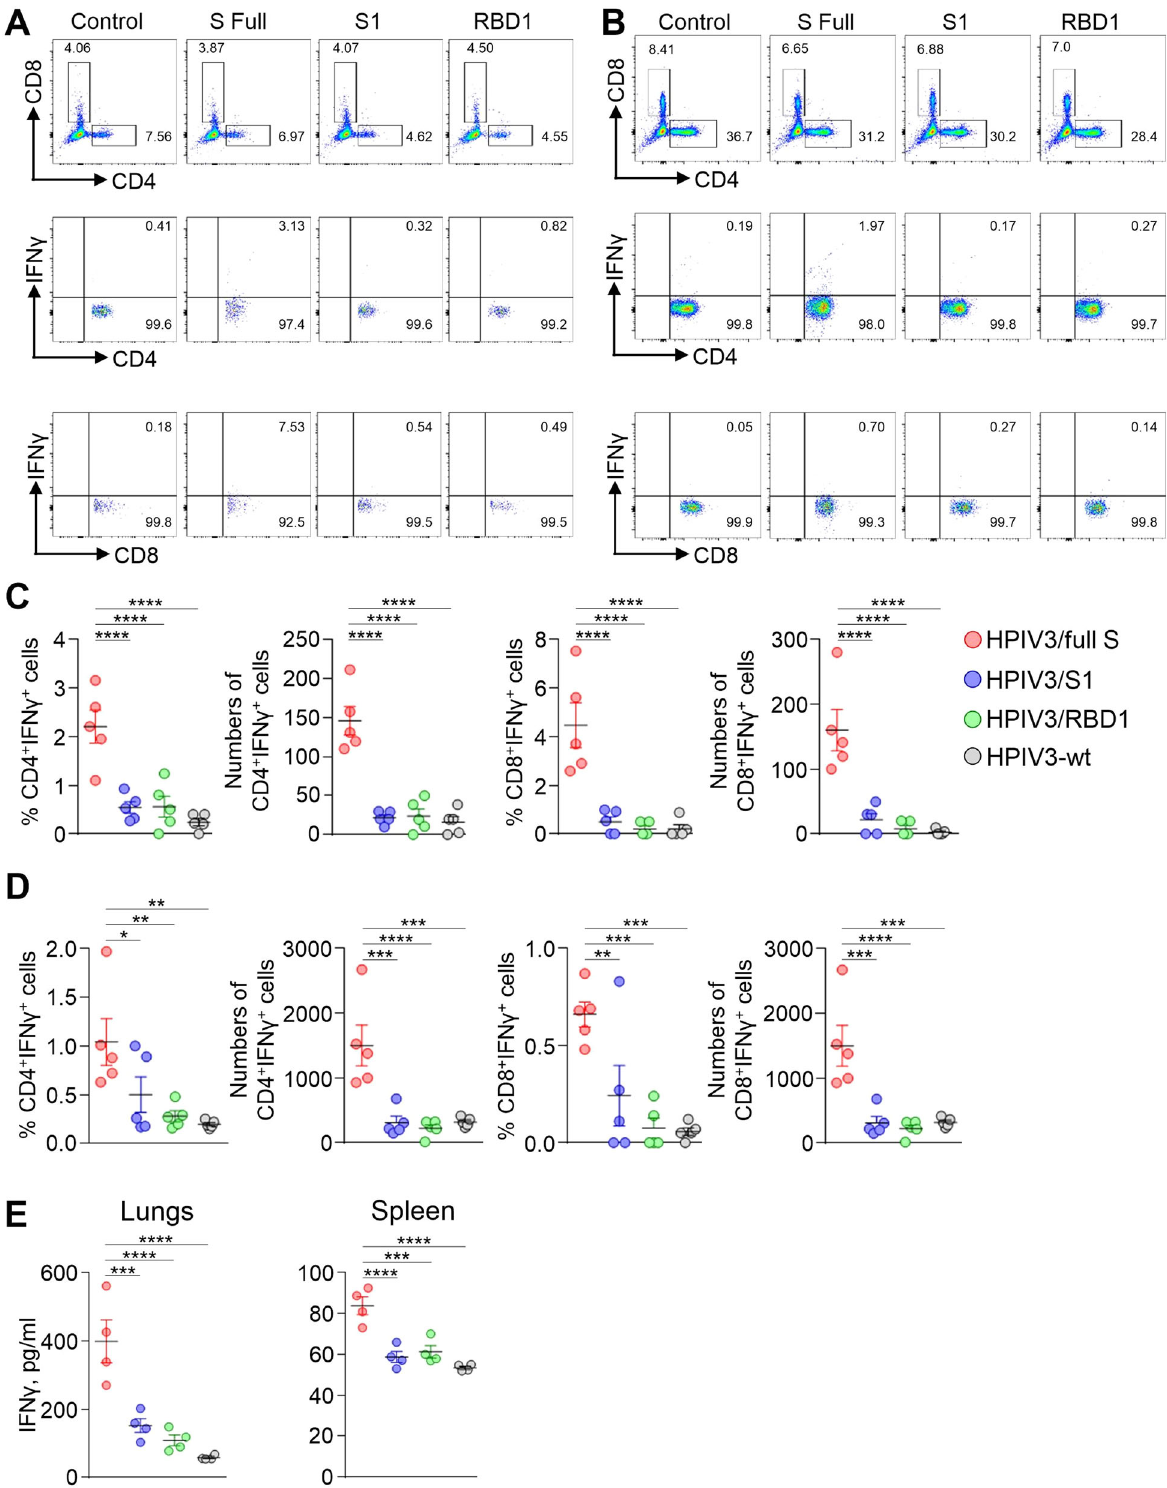
Fig. 4 Cell-mediated response to vaccination in lungs and spleen. A – D Cells isolated from tissue samples of uninfected animals at 28 days post vaccination were stimulated with SARS-CoV-2 S-peptide pool and stained for CD4, CD8 and IFN γ markers. A and B . Representative histograms show the frequency of CD4 + and CD8 + T cells (gated from lymphocyte population) and IFN γ -positive CD4 + or CD8 + T cells following treatment with S peptides in lungs ( A ) or spleen ( B ). C and D Frequency and absolute numbers of T cells per 10 6 total lung cells ( C ) or spleen cells ( D ). E IFN γ secretion by lung and spleen cells at 28 days post vaccination. Cells were isolated from tissue samples of uninfected animals and stimulated with SARS-CoV-2 S-peptide pool. The level of IFN γ was determined in supernatants of cultured cells by ELISA. Data represent mean ± SEM of 4 – 5 animals per group. * p < 0.05; ** p < 0.01; *** p < 0.001; **** p < 0.0001 (one-way ANOVA with multiple comparisons, Fisher ’ s LSD